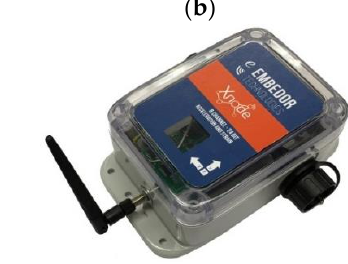
Figure 1. Xnode smart sensor: ( a ) three-board stack and ( b ) enclosure.